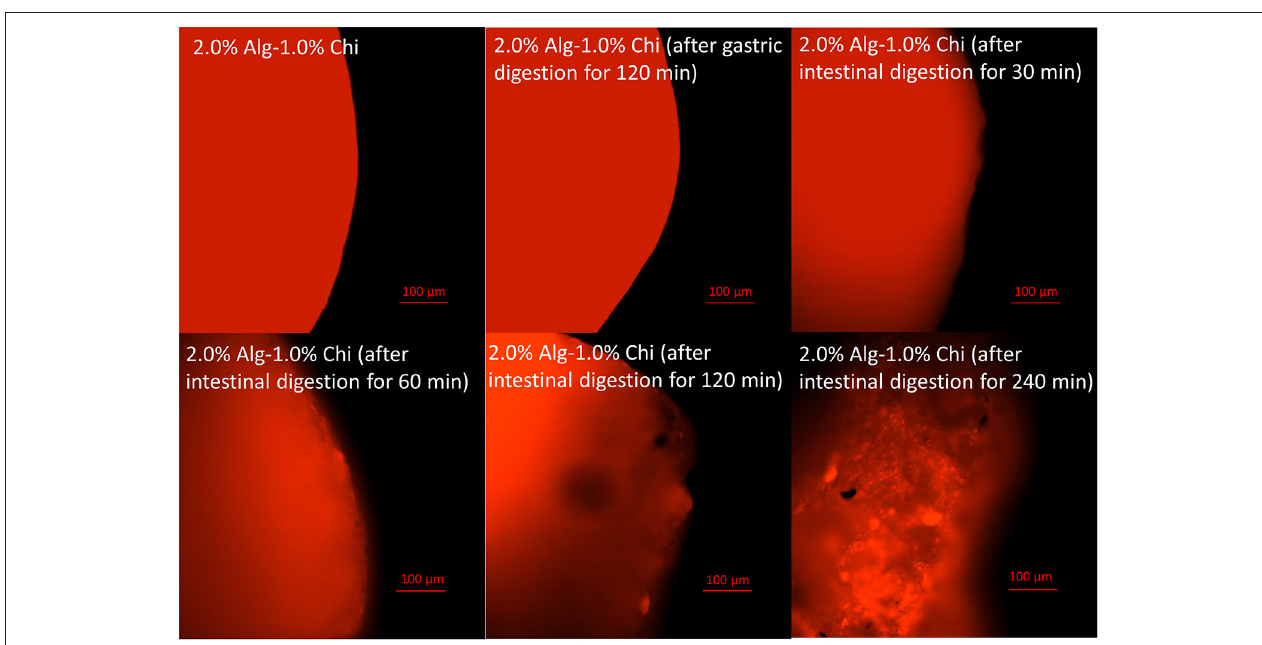
FIGURE 6 | Fluorescent images of alginate-chitosan hydrogel beads immobilized Pickering emulsion surface after gastric and intestinal digestion (scale bar, 100 µ m).